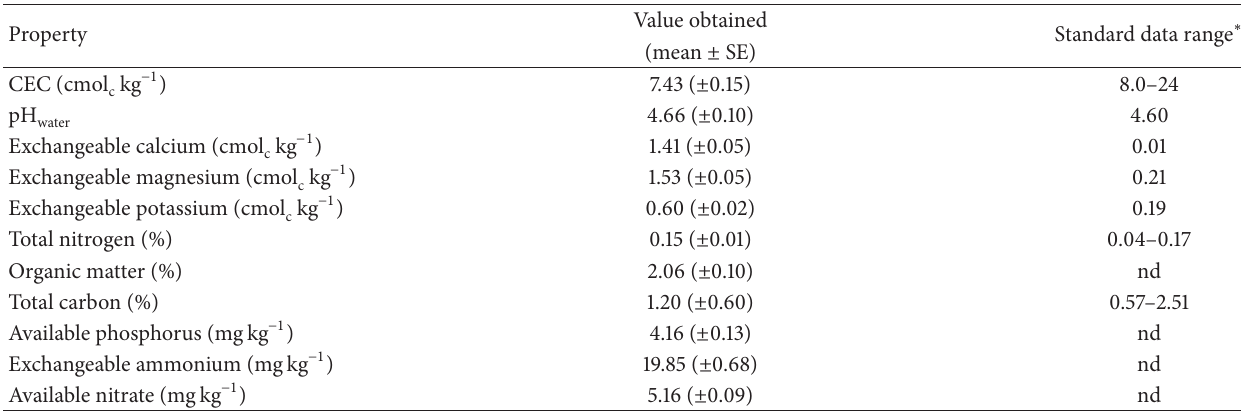
Table 1: Selected chemical properties of Bekenu Series.